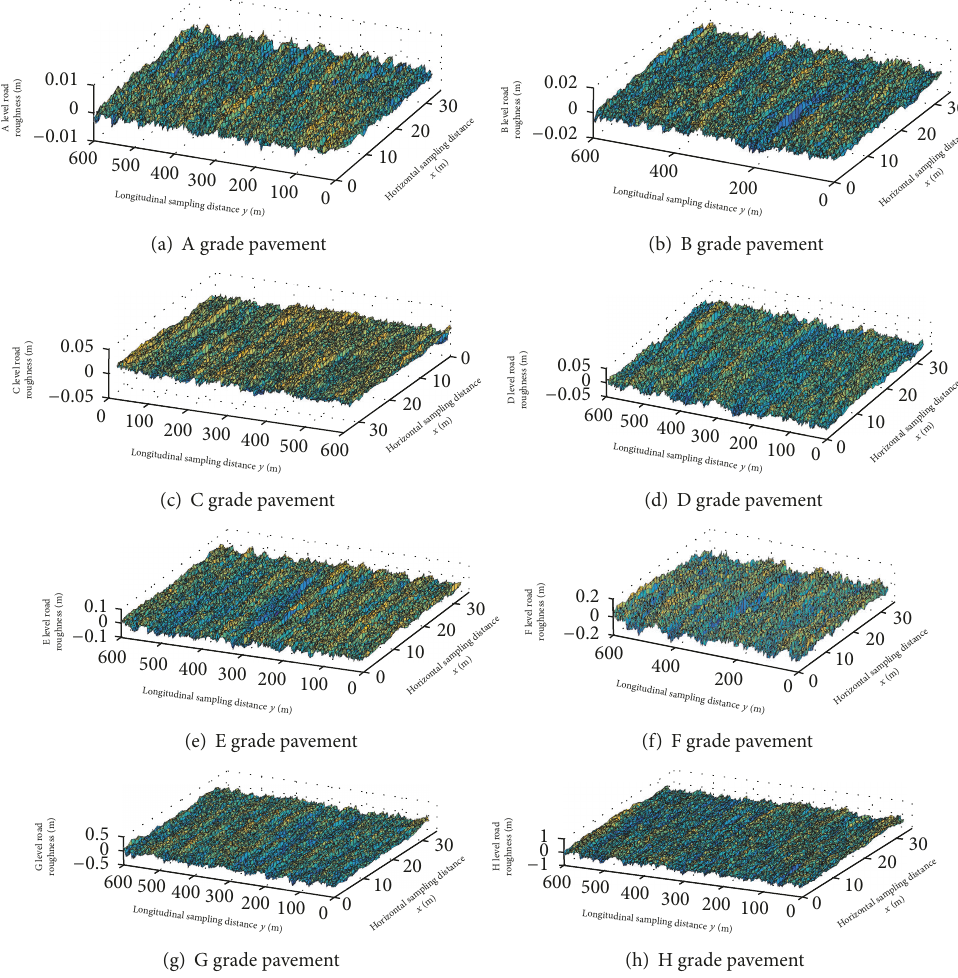
Figure 3: Reconstruction of three-dimensional rough